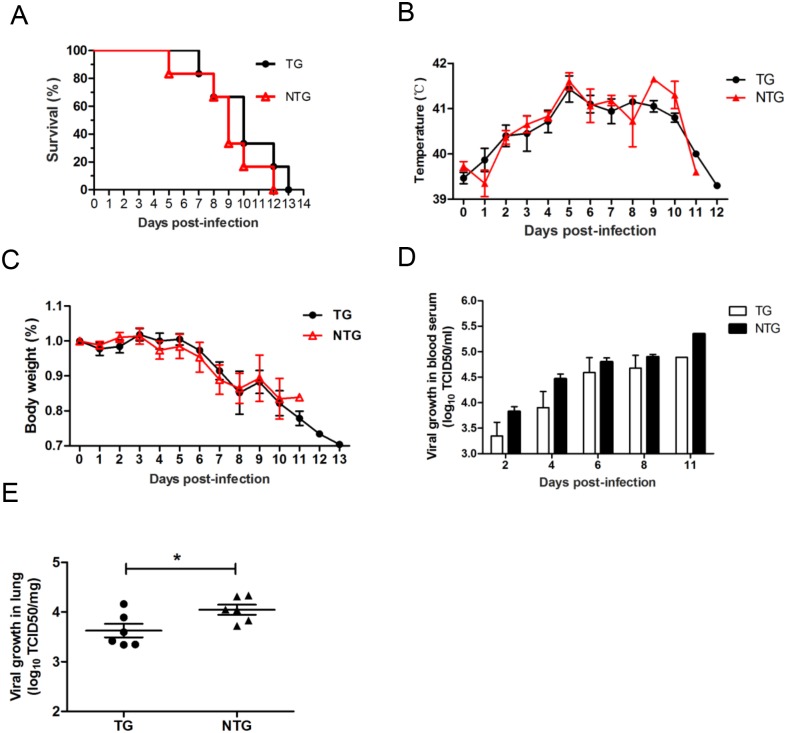
Transgenic pigs developed a lower level of viremia and had a lower virus load in the lungs.(A) Survival curves for the pigs in the two challenged groups after infection with PRRSV JXA1. The pigs in challenged TG group survived for a longer period than the pigs in the challenged NTG group (log rank test; P = 0.328). Group: challenged TG group, n = 6; challenged NTG group, n = 6. (B) Rectal temperature curves for the pigs from the two challenged groups after infection with PRRSV JXA1. (C) Body weight curves for pigs in the two challenged groups after infection with PRRSV JXA1. (D) Analysis of the viral loads in serum samples obtained from challenged TG and challenged NTG pigs at the indicated times. (E) Viral load in the lungs. The samples were collected from the lungs of dying challenged TG and challenged NTG pigs. The data in panels B, C, D and E are presented as the mean±SD. The data in panels B, C, D and E were analyzed using Student’s t-test. *, P<0.05.